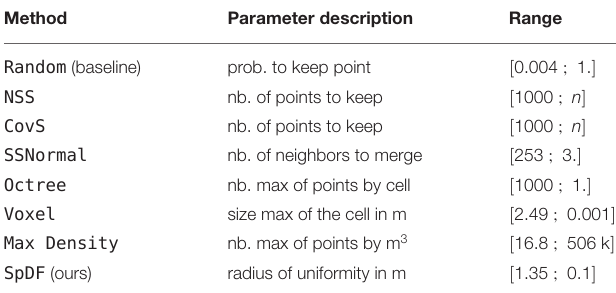
b ] of parameters influencing the number of points, where a TABLE 3 | Ranges [ a ; gives the smallest number of points (here, 1,000 points) and b preserves all the points (with n being the total number of points), for each evaluated method with their